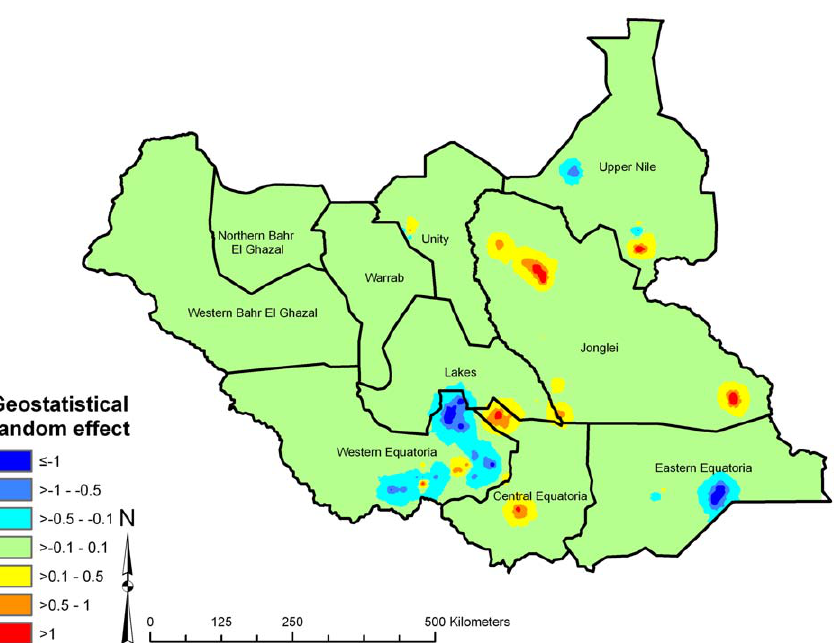
Figure 6. Spatially structured residual variation in prevalence of active trachoma in children aged 1–9 years, Southern Sudan, 2001–2009, after accounting for rainfall, land cover and age and sex of survey participants. Estimates were derived using a geostatistical